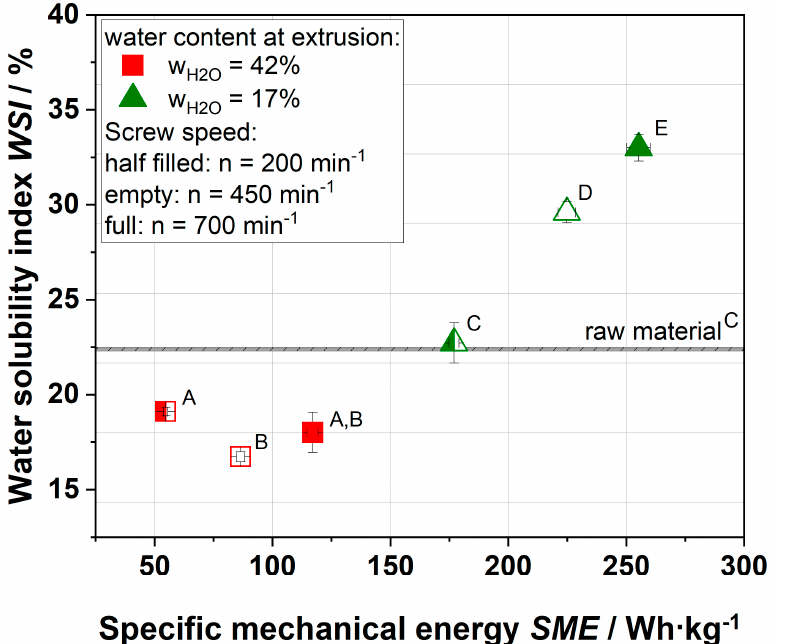
Figure 4. E ff ect of specific mechanical energy (SME) on the water solubility index (WSI) of apple pomace. The apple pomace was extruded at water contents of 17 (triangular) and 42% (square); screw speeds were 200 (half-filled), 450 (empty), and 700 (full) min − 1 . A–E Mean values within a row that are marked with di ff erent letters di ff er significantly ( p <